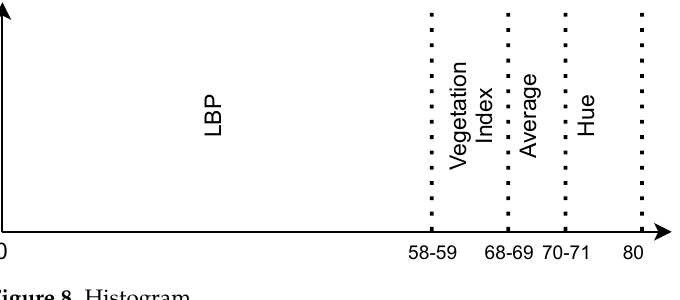
Figure 8. Histogram.